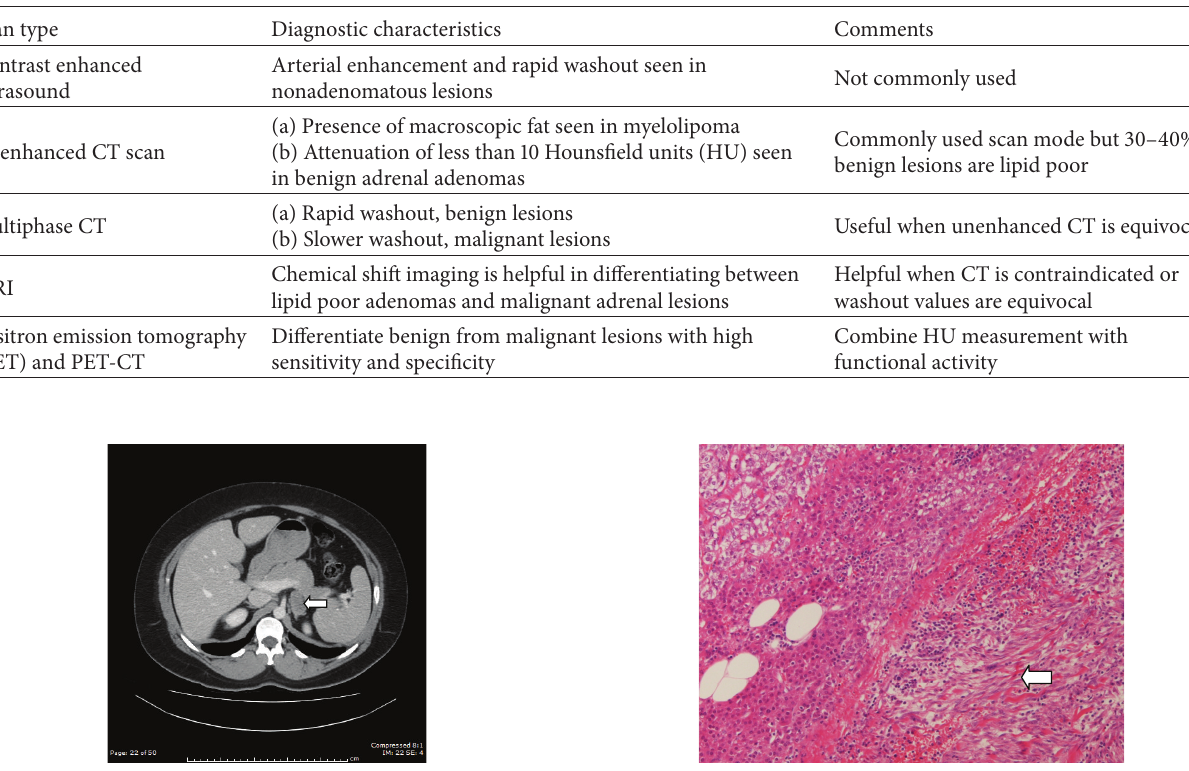
Table 1: Adrenal imaging modalities and their utility.